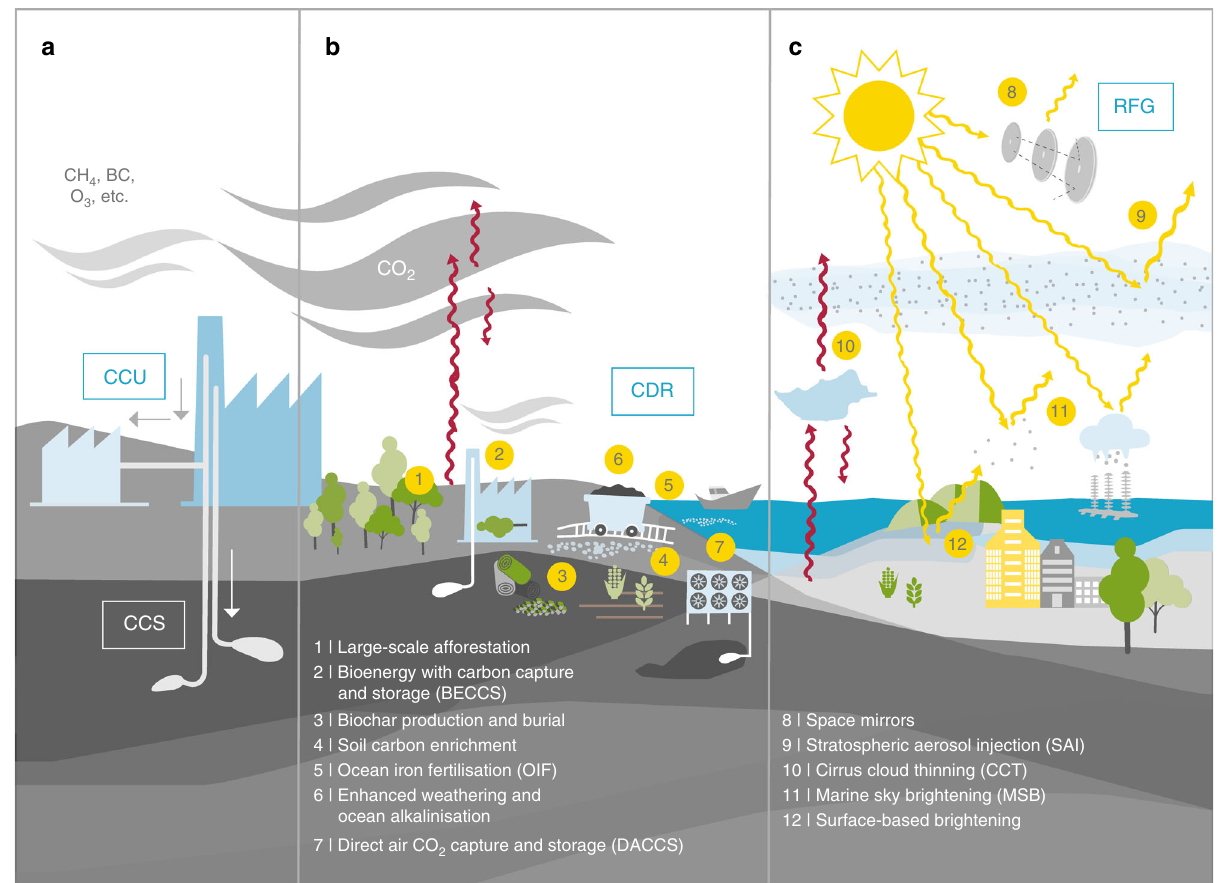
Fig. 1 Proposed climate geoengineering techniques focused on in this review, placed in the context of mitigation efforts. a Mitigation is de fi ned here as reducing the amount of CO 2 and other climate forcers released into the atmosphere by either reducing the source activities (e.g., less energy consumption), increasing ef fi ciency (thus reducing emissions per unit of the activity, e.g., kWh of energy produced), or removing forcers like CO 2 directly at the source prior to their emission, e.g., from the concentrated stream of CO 2 at power or industrial plants. For the latter, the captured CO 2 can either be stored subsurface (CCS — carbon capture and storage), or utilized in long-lived materials such as carbonate-based cement (CCU — carbon capture and utilization). b In contrast to mitigation (including CCS and CCU), carbon dioxide removal (CDR) aims to reduce the amount of CO 2 after it has been emitted into the ambient atmosphere, thus reducing greenhouse warming due to the absorption of terrestrial radiation (red arrows). The main proposed techniques are based on uptake of CO 2 either by photosynthesis (techniques 1 – 5) or by abiotic chemical reactions (techniques 6 and 7), followed by storage of the carbon in various biosphere or geosphere reservoirs. c Radiative forcing geoengineering techniques aim to modify the atmosphere-surface radiative energy budget in order to partly counteract global warming, by two distinct approaches: increasing the amount of solar shortwave radiation (yellow arrows) that is re fl ected back to space (techniques 8, 9, 11, and 12), or increasing the amount of terrestrial longwave radiation which escapes to space (technique 10). The focus of this class of techniques is on inducing a negative radiative forcing (i.e., cooling). Thus, in place of the commonly used misnomers solar radiation management (SRM) and albedo modi fi cation 14,15,17 , which focus only on the solar radiation techniques and exclude